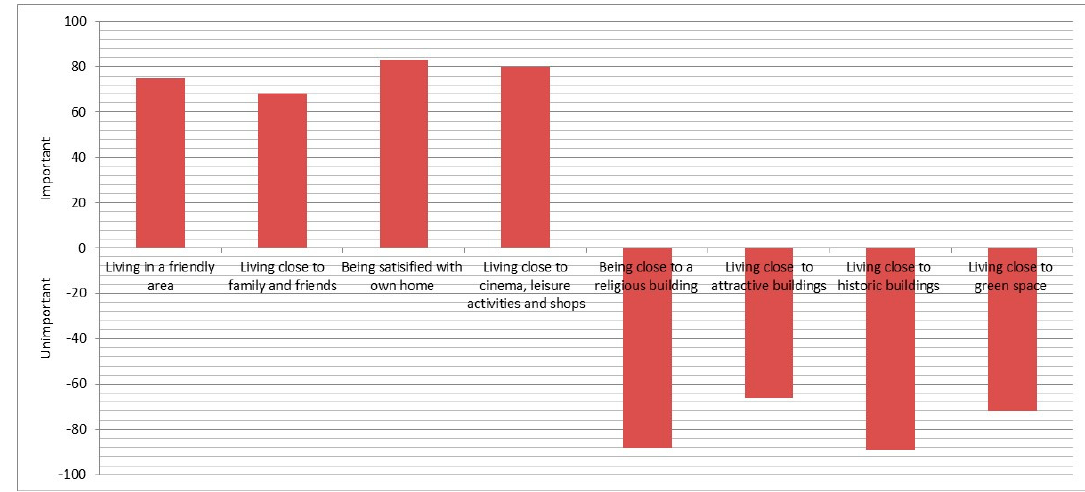
Figure 2. Importance rating of factors contributing to making somewhere a good place to live.